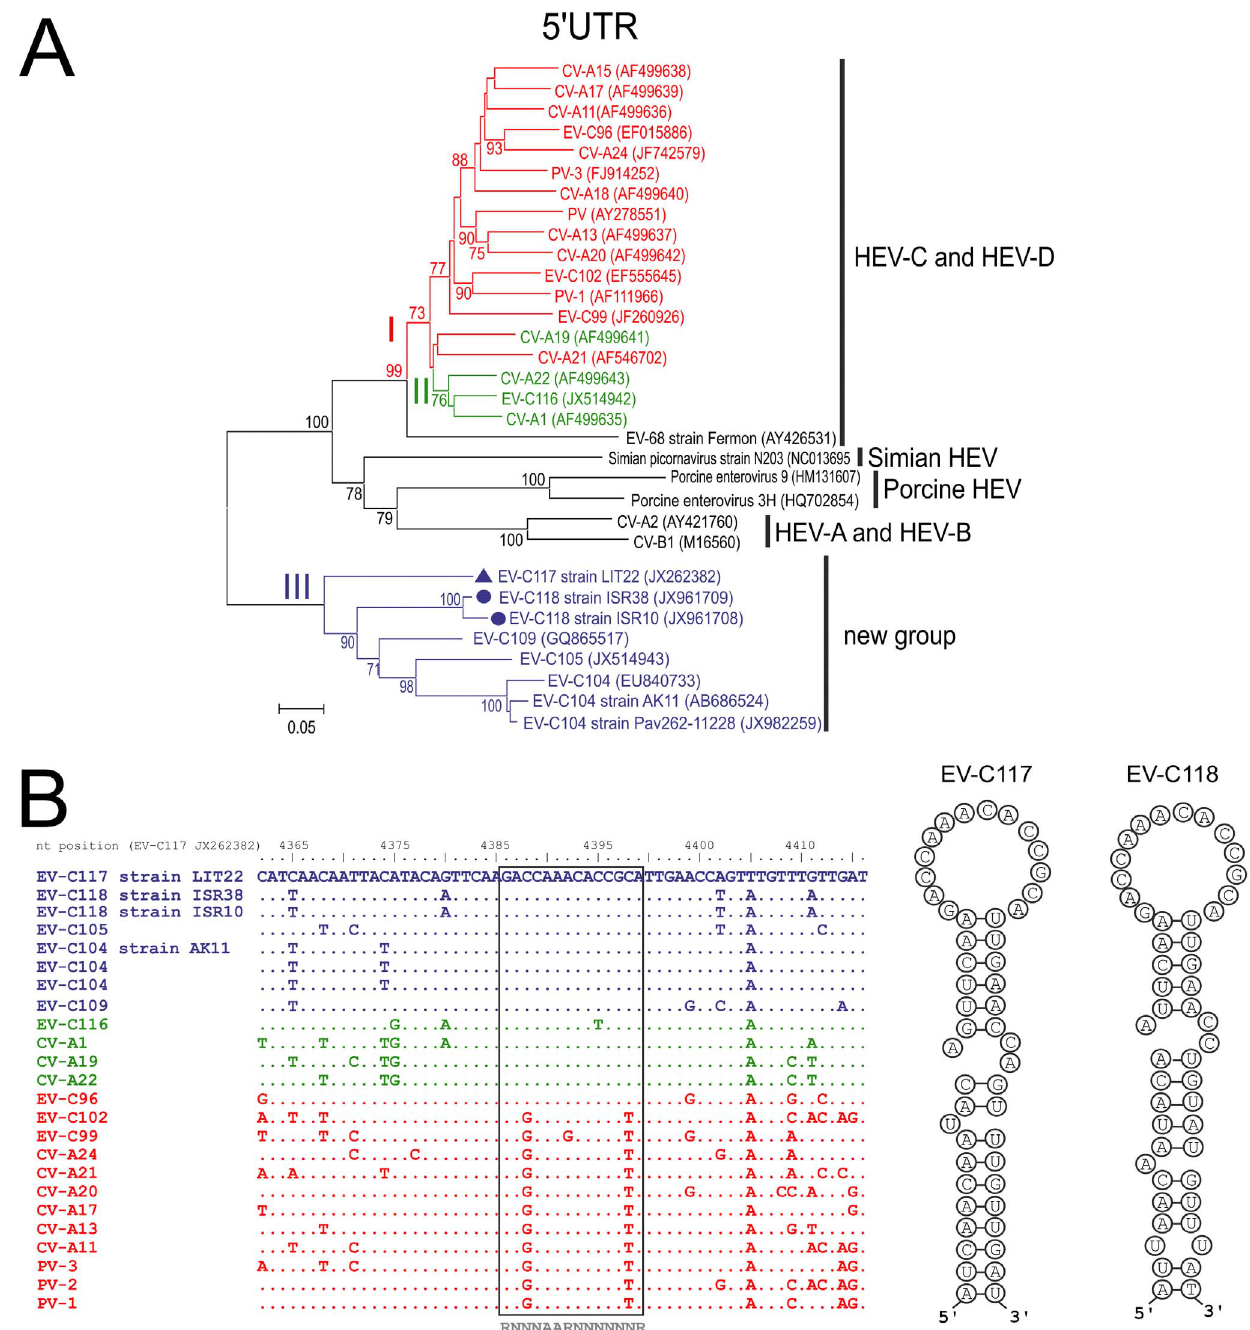
Figure 1. A phylogenetic tree based on 5 9 UTR sequences and showing the genetic relationships between enteroviruses (A). Nucleotide alignment of the 2C region containing the cre element in HEV-C (B).